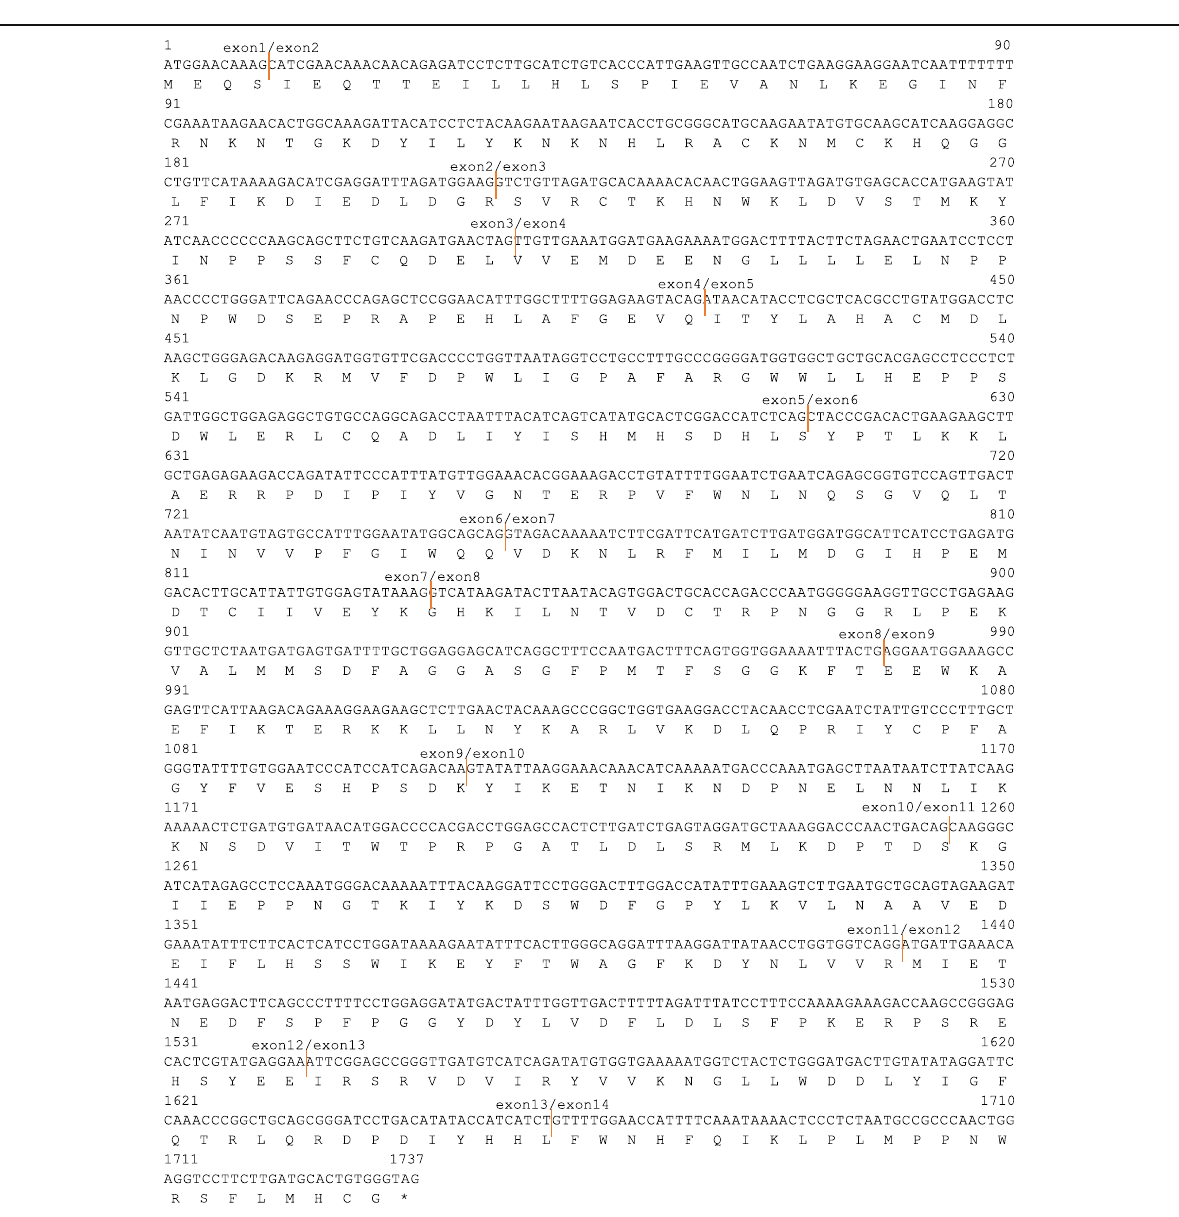
Fig. 2 Nucleotide sequence and exon borders of the coding region of the dog CMAH gene. Orange bar: exon boundaries resulting from comparison of nucleotide sequence of the dog CMAH cDNA with the dog genome sequence (NC_006617.3). Number above each line is number of nucleotide sequences. Under line: Start Codon, *: Stop